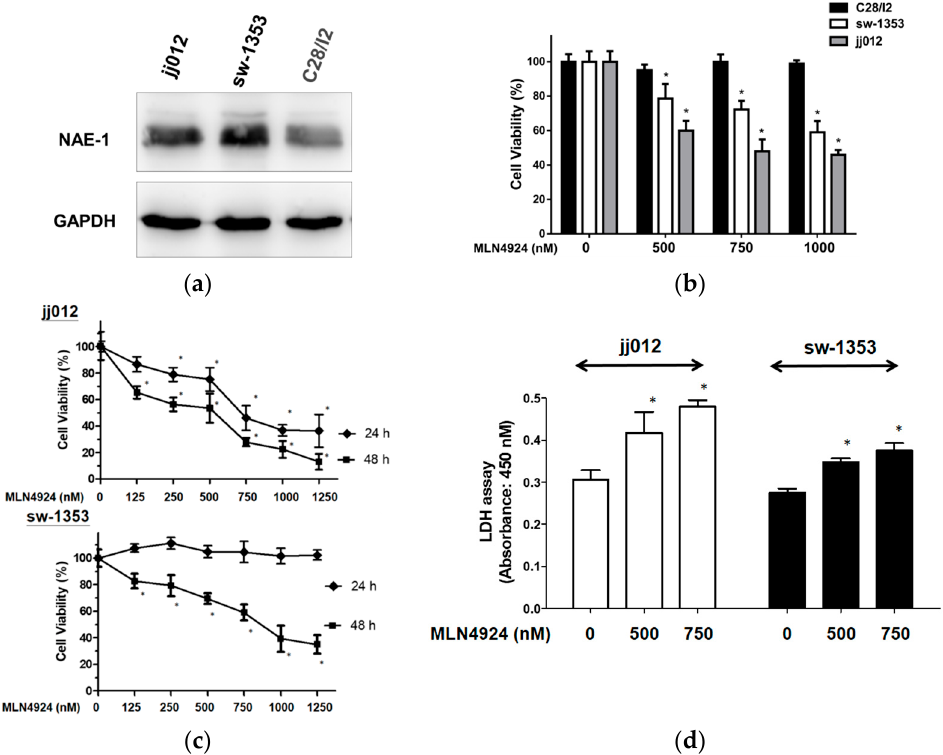
Figure 1. MLN4924 reduced cellular viability and induced cytotoxicity in human chondrosarcoma cells. ( a ) NAE-1 expression in human chondrosarcoma cell lines (jj012, sw-1353), and normal chondrocyte cell line (C28/I2). ( b ) The jj012, sw-1353, and C28/I2 cells were treated with various 121 concentrations of MLN4924 for 24 h. A WST-1 assay was performed to assess cell viability. ( c ) The 122 jj012 and sw-1353 cells were treated with various concentrations of MLN4924 for 24 and 48 h in a 123 WST-1 assay. ( d ) The jj012 and sw-1353 cells were treated with dimethyl sulfoxide ([DMSO], as a 124